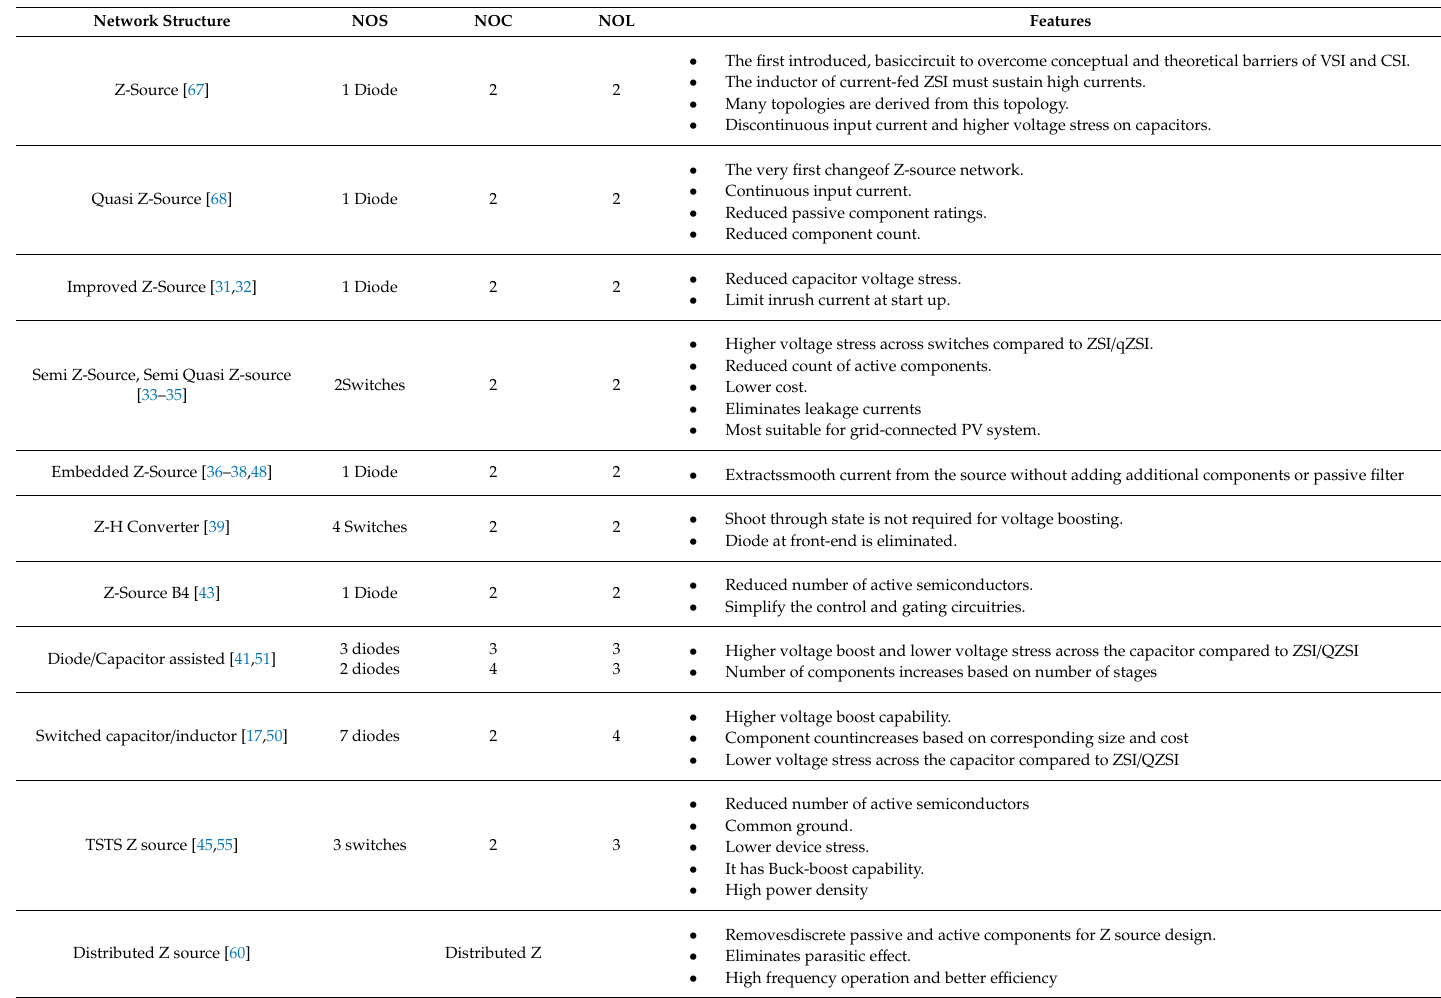
Table 3. State of art PV grid inverter topologies of transformer less Z source